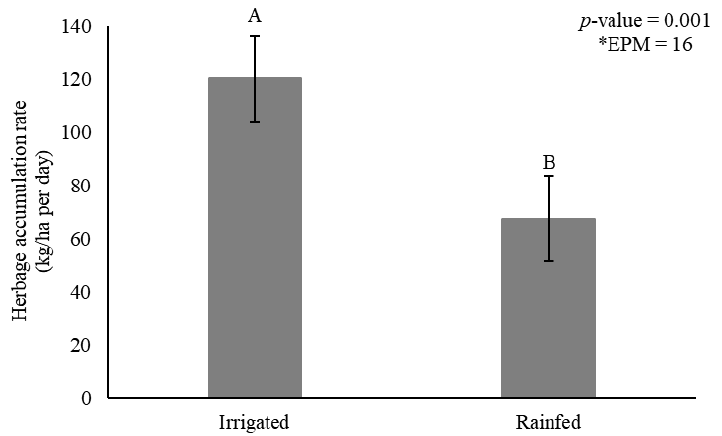
Figure 2. Herbage accumulation rate (HAR) (kg dry matter/ha per day) as affected by irrigation for elephantgrass genotypes at Garanhuns, Pernambuco, Brazil. *EPM = Standard error of the means. Table 1. Herbage accumulation rate (HAR) and stem accumulation rate (SAR; kg dry matter/ha per day), as affected by the interaction between genotype and season for elephantgrass genotypes at Garanhuns, Pernambuco, Brazil.